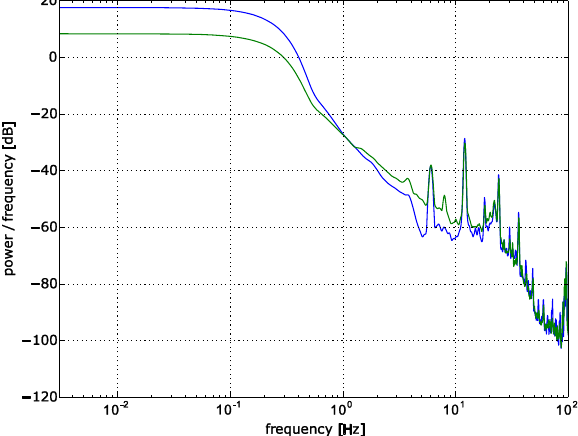
Figure 14. Power spectral density of the pitch angle – Welch approach. Flight lines with stabilization – green, flight lines without stabilization – blue. Flight